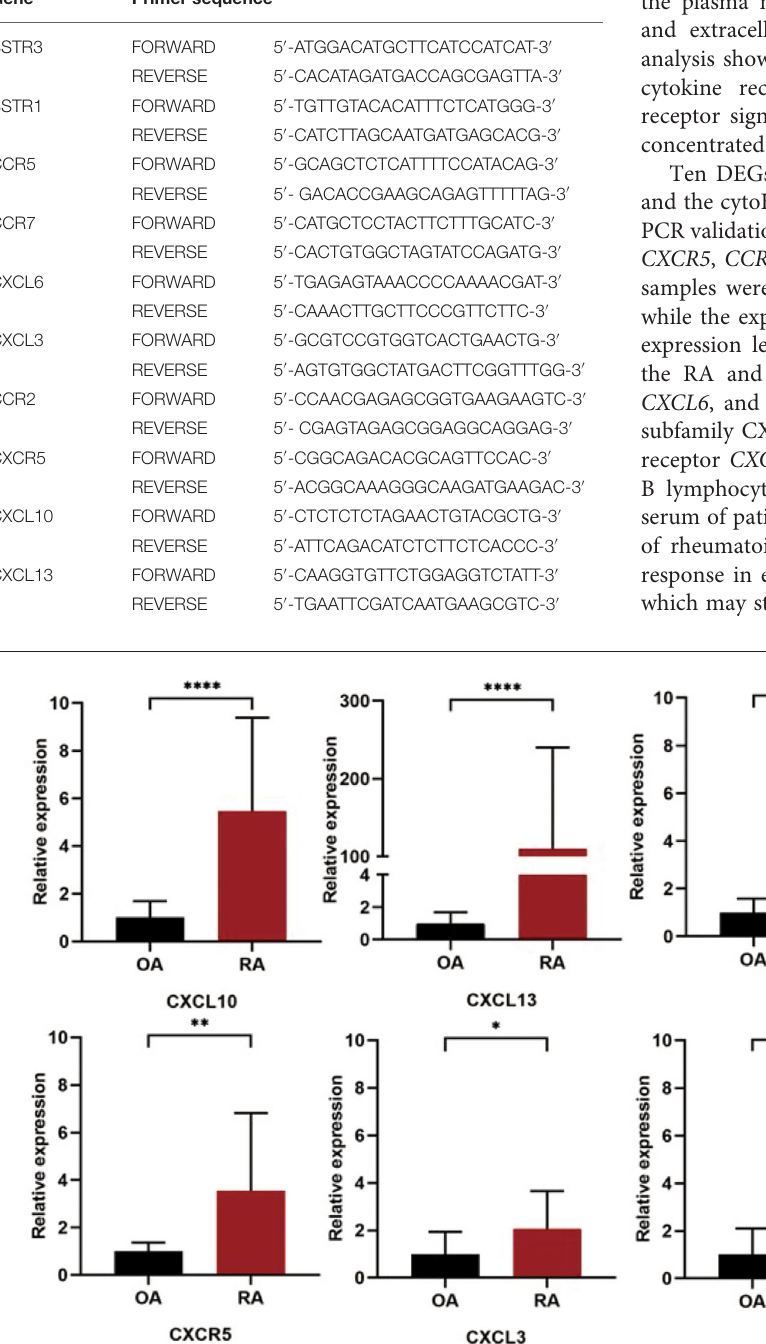
Frontiers in Medicine |